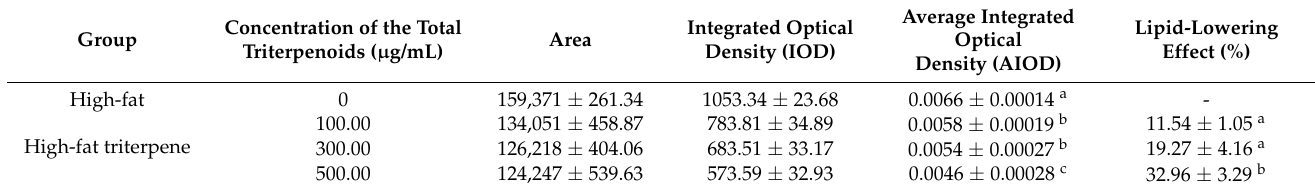
Table 4. The analysis of the optical density in the zebrafish lipid